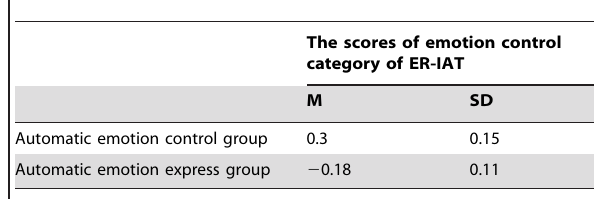
Table 1. The scores of emotion control category of ER-IAT of automatic emotion control group and automatic emotion express